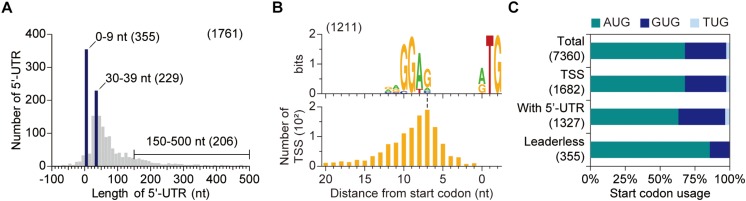
Determination of 5′-UTR. (A) The distribution of 5′-UTR length. Only primary transcription start sites assigned to coding DNA sequences were considered. (B) Conserved ribosome binding site (RBS) sequences of S. lividans. RBS sequence was discovered using up to 25 nt sequences upstream of start codon when the 5′-UTR is longer than 10 nt. (C) Start codon preference dependent on 5′-UTR length. AUG is preferred as a start codon for leaderless mRNA.